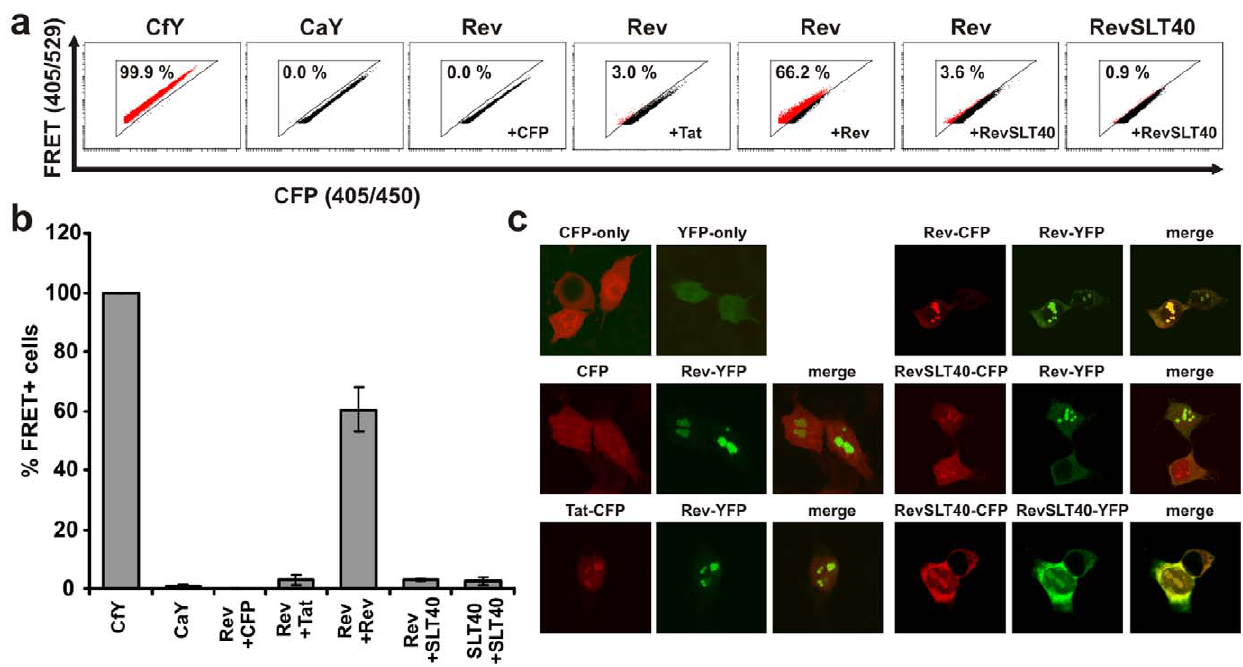
Figure 4. Measurement of HIV-1 Rev multimerization by FACS-FRET. (a) Representative primary FACS-plots showing the amount of FRET + cells in living 293T cells cotransfected with the indicated CFP and YFP fusion proteins. (b) Mean values and standard deviations (SD) for the total amount of FRET + cells from four independent experiments that were analysed as depicted in (a). (c) Confocal images of 293T cells that were cotransfected with the indicated YFP (shown in green) and CFP (shown in red) fusion